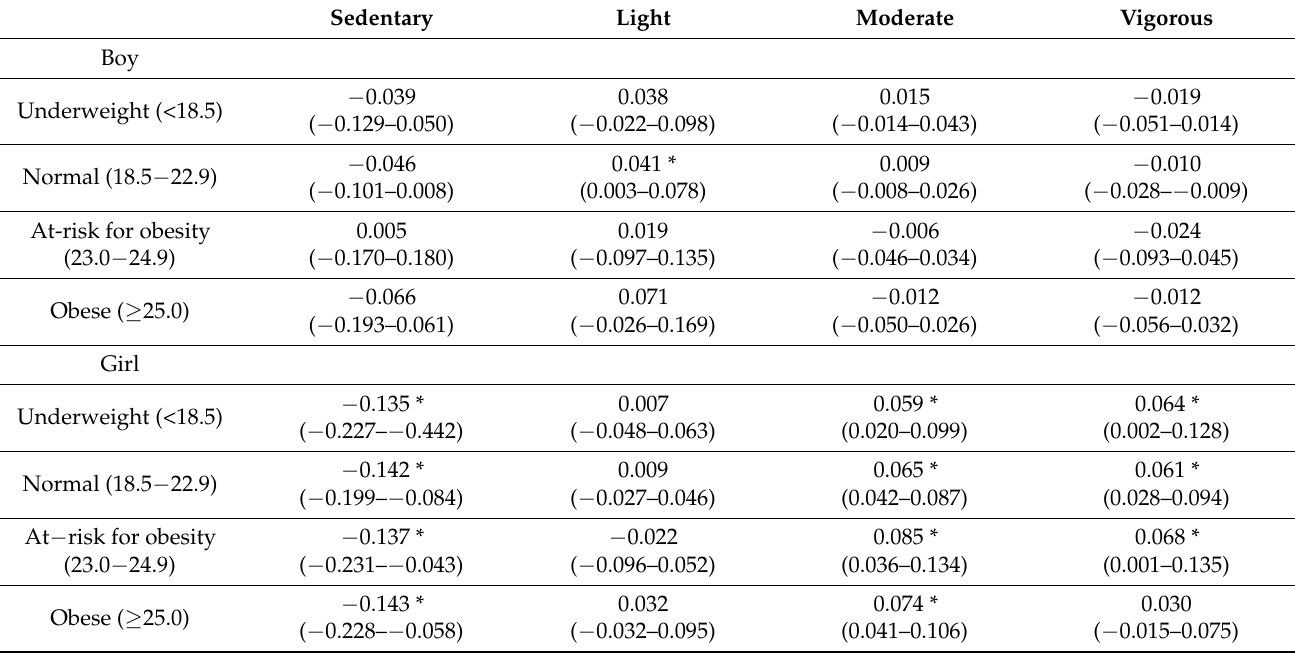
Table 3. Differences in physical activity time by game play time in physical education class for each obesity group.